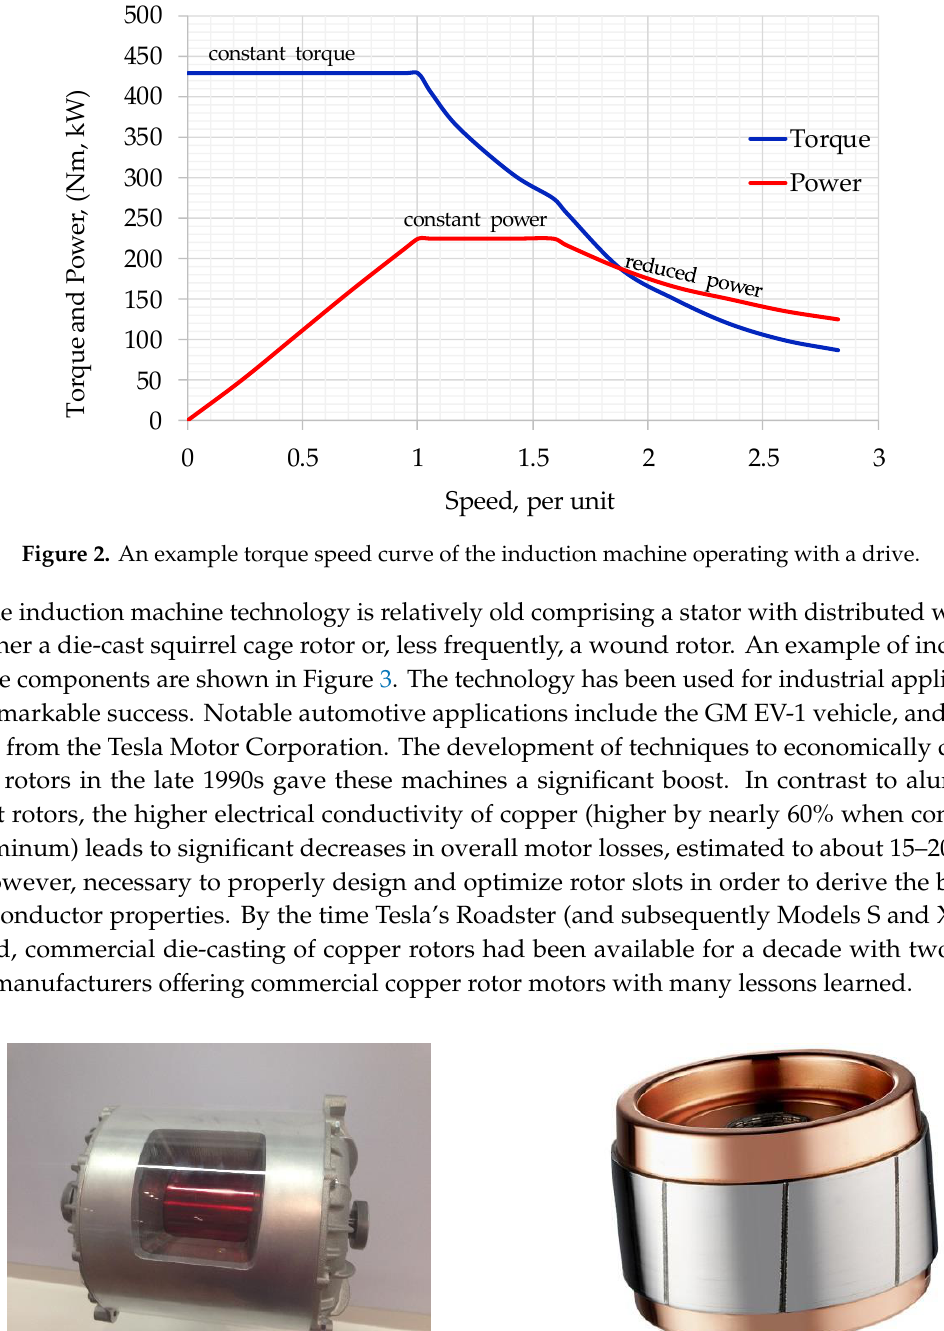
Figure 3. Induction machine components, showing: ( a ) Tesla motor cut-out [36], and ( b ) die-cast copper rotor [37].